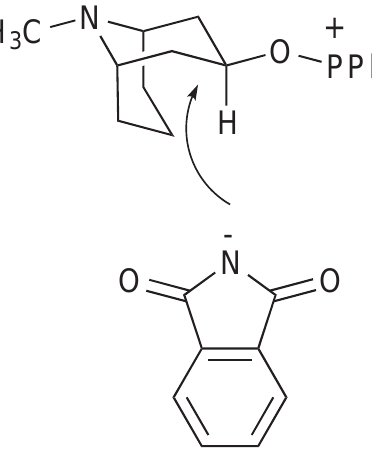
Fig. 3 Steric hindrance for the α attack on compound 12